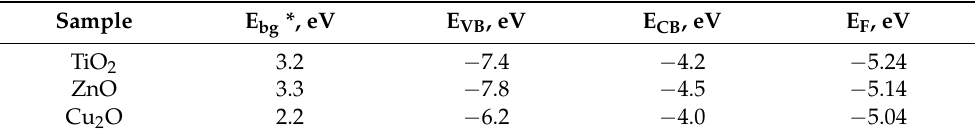
Figure 1. Low binding energy XPS spectra of the components of heterostructured coatings: 1, Cu 2 O; 2, TiO 2 ; and 3, ZnO. Table 2. Positions of the conduction and valence bands and band gap energies of the coating components with respect to vacuum energy level.